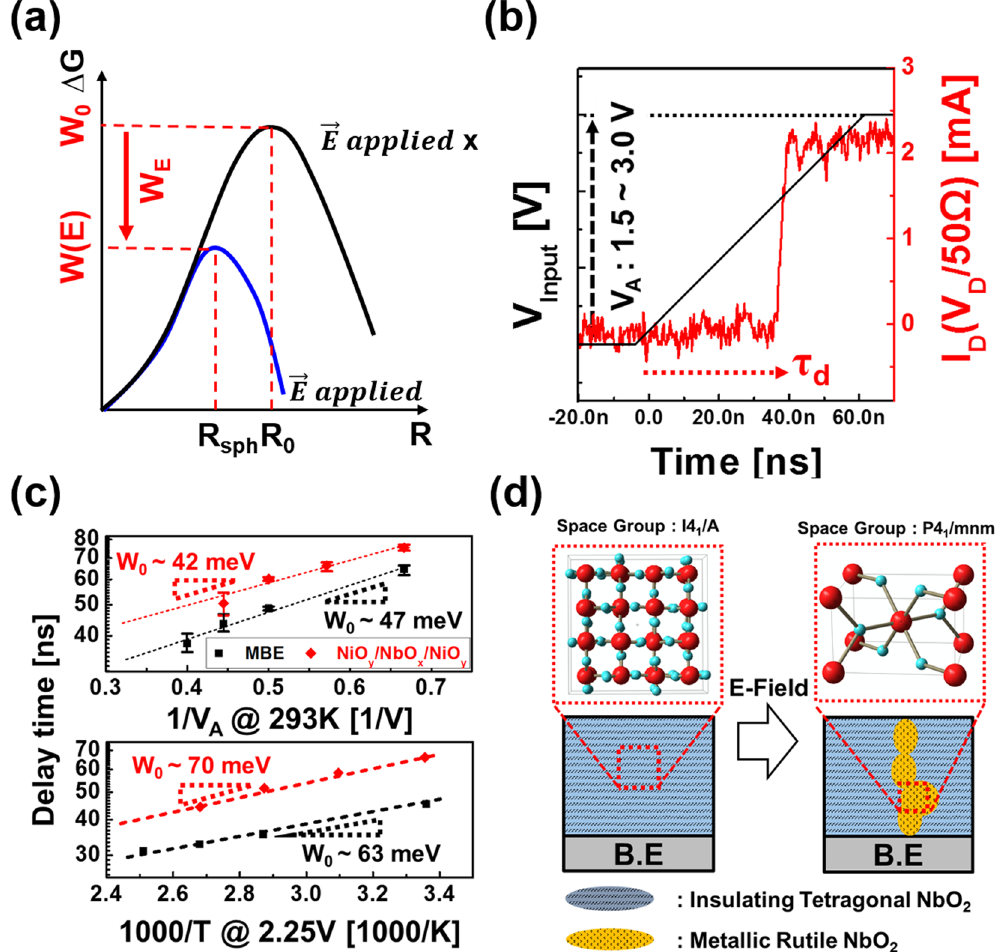
Figure 2. ( a ) Energy barrier W 0 to nucleate without E-field can be lowered by E-field. W(E) is effective barrier energy to nucleate with E-field. ( b ) Measurement example to detect the delay time predicted by the nucleation theory during IMT. ( c ) Arrhenius’s plot of delay time versus voltage and temperature of NbO 2 film. ( d ) The schematic diagram of phase transition: the transition is the result of Pielers phase